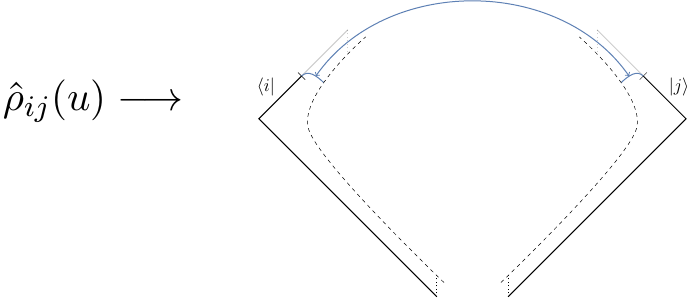
Figure 19. The boundary conditions corresponding to the operator ˆ ρ ij ( u ) . We have flat asymp- totic regions as pictured, with matter boundary conditions at I u specified by the states | i i , | j i . The Cauchy slices meeting I + at time u must be identified as shown in the asymptotic re- gion. We do not specify what happens to the spacetime away from the asymptotic region, inside the dashed curved. In particular, this allows the spacetime to connect with other boundaries, and the future Cauchy slices need not be identified in the same way in their entirety. For ex- ample, the spacetimes in figure 15 involve two copies of such boundary conditions, computing Tr( ρ (2) ( u ) 2 ) = P h HH | ˆ ρ ij ( u )ˆ ρ ji ( u ) | HH i ij